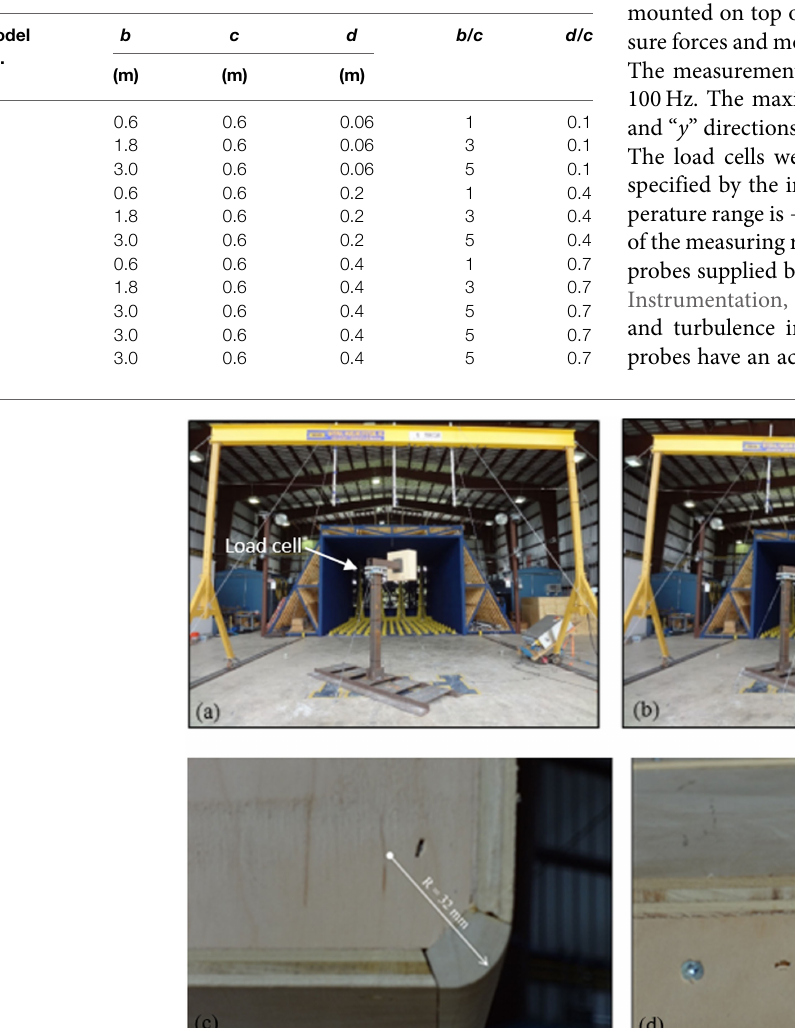
Frontiers in Built Environment |